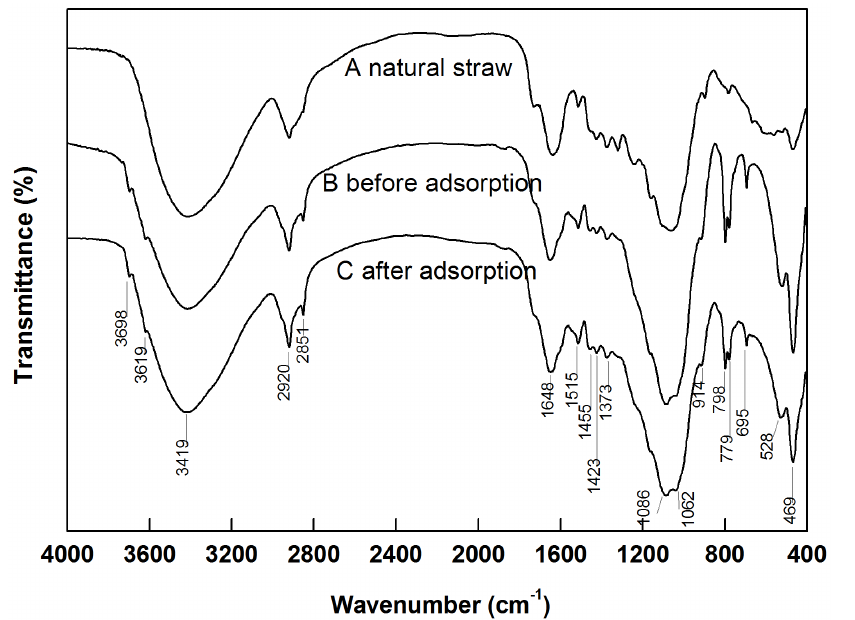
Figure 4. FT-IR spectra of natural dried rice straw and the rice straw residue at 110 d before and after potassium (K) adsorption. Solid line A represents the infrared spectrum of natural dried rice straw. Solid lines B and C represent the infrared spectra of the rice straw at 110 d before and after K adsorption in 50 mg L 2 1 KCl solution, respectively. The data in the panel are the peak wavenumbers.